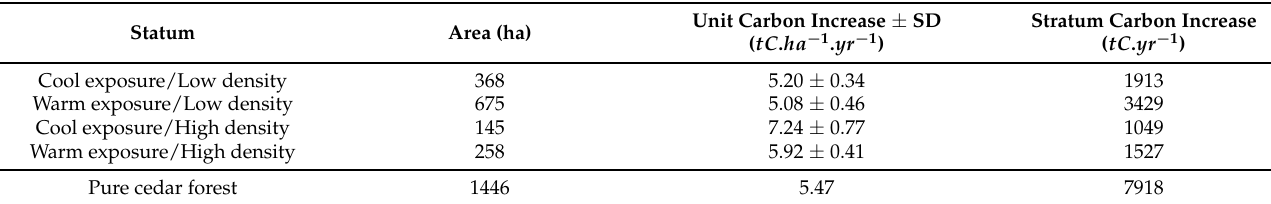
Table 8. Carbon increment per stratum